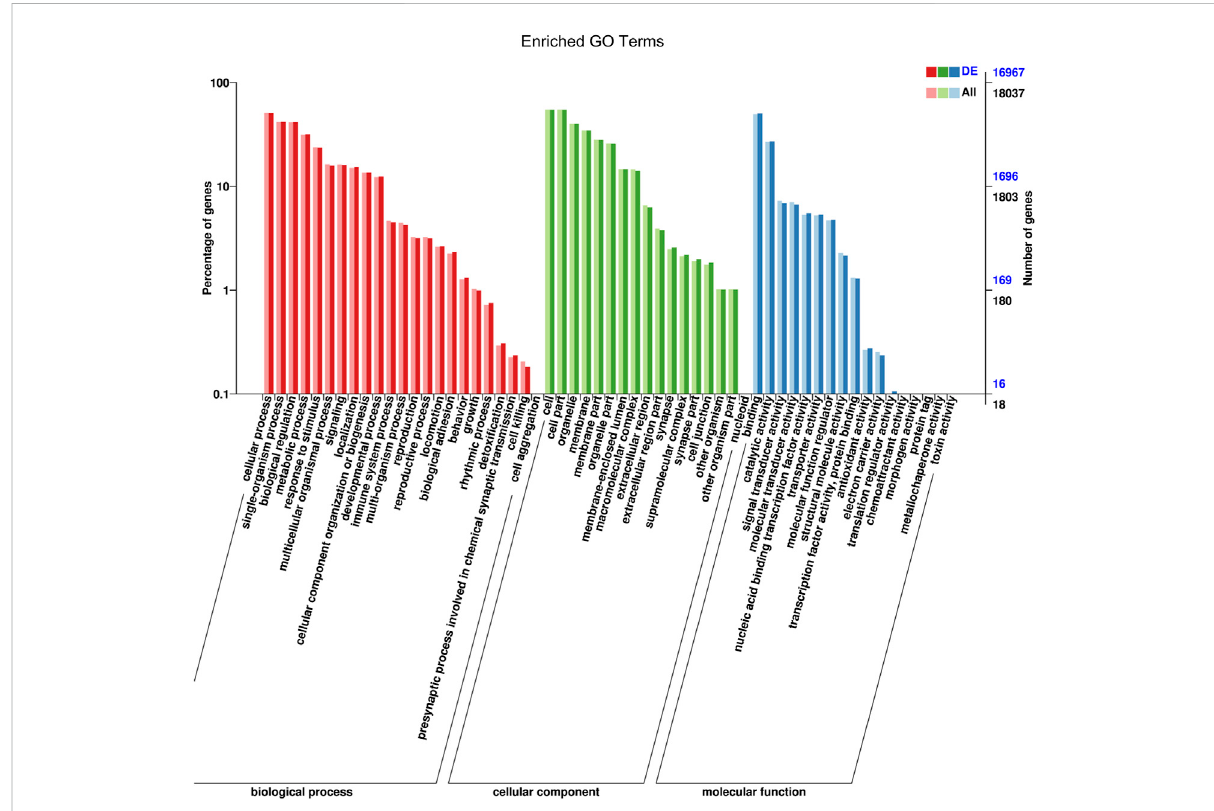
FIGURE 5 GO function classi fi cation target genes of known differential expressed miRNAs in AR patients compared with non-AR patients. Abscissa: class classi fi cation. The three different classi fi cations represent the three basic classi fi cations of GO terms. From left to right they are biological process, cellular component, and molecular